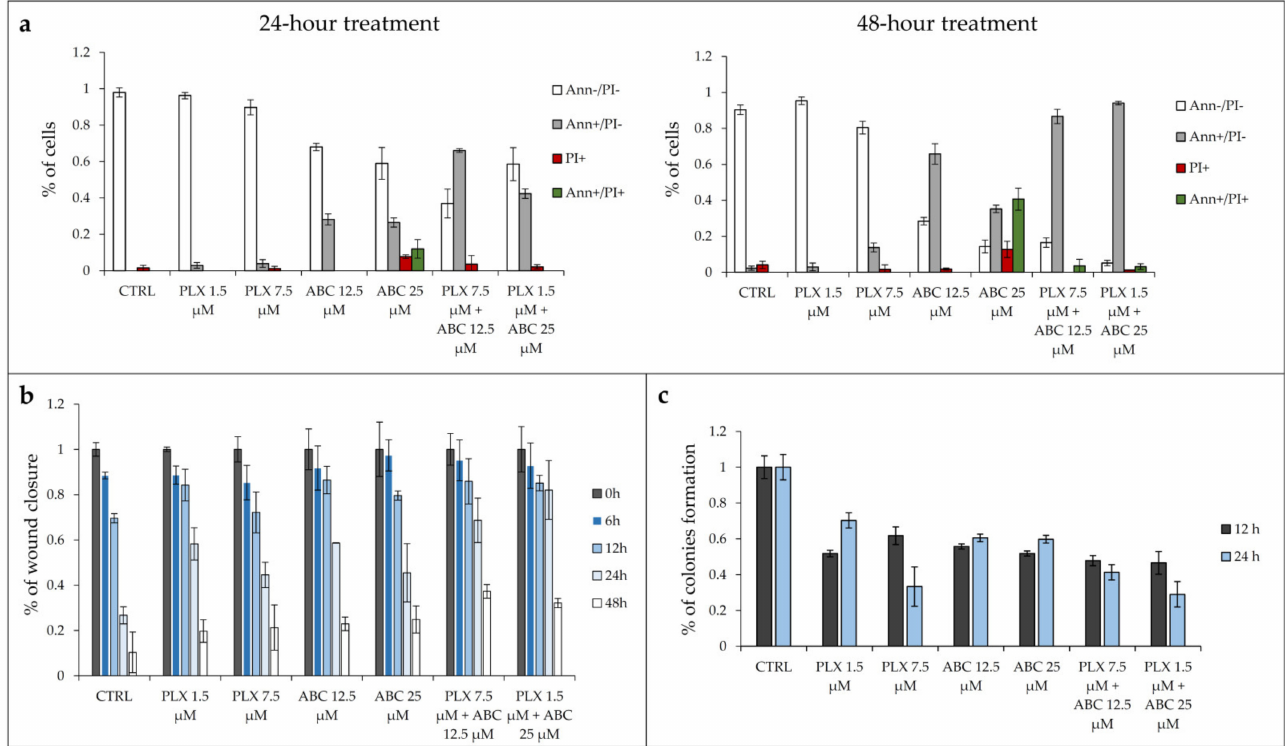
Figure 5. Effect of combination treatment with ABC294640 and PLX4032 on apoptosis induction, migration and colony forming ability of vemurafenib-resistant RKOr cell line. ( a ) Annexin V assay was performed to detect induction of apoptosis when cells were treated with either single agents or their combination for 24 and 48 h. Data were obtained from two independent biological experiments in two technical replicates and represent the percentage of viable cells (Ann-/PI-), early apoptotic cells (Ann+/PI-), late apoptotic/primary necrotic cells (Ann+/PI+) and secondary necrotic cells (PI+). Ann (Annexin V); PI (propidium iodide). ( b ) A wound healing assay was performed in RKOr cells treated with either single agents or their combination for 6, 12, 24 and 48 h. Data were obtained from two individual biological experiments performed in technical duplicates. ( c ) A clonogenic assay was caried out in RKOr cells treated with either single agents or their combination for 12 and 24 h followed by a one-week incubation to allow the formation of colonies. Data were